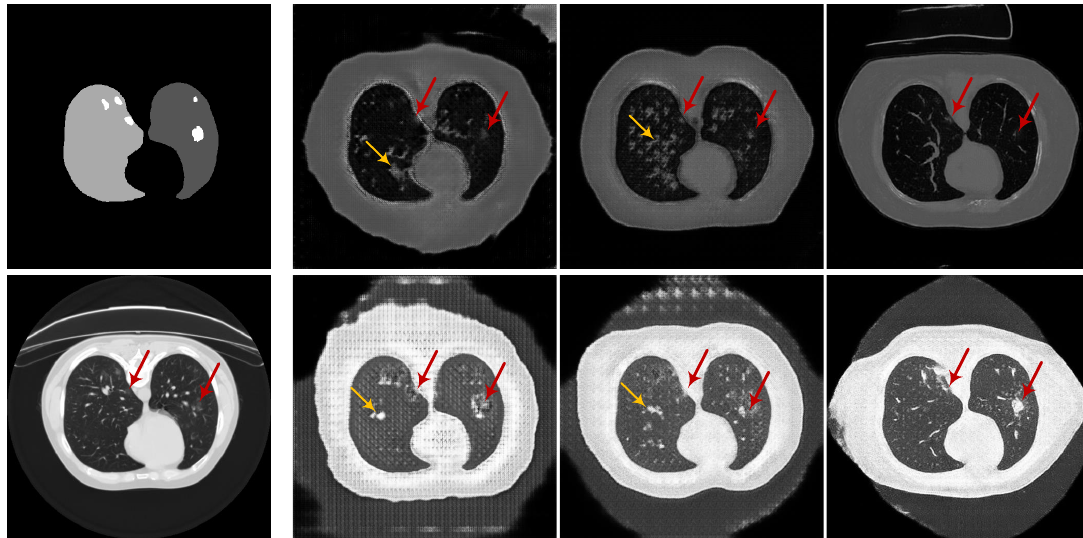
Figure 11. Comparison of synthetic radiological images from different generative models given the same input condition. The input condition and the reference ground-truth radiological image are depicted in the first column. The last three columns are the results of pix2pix, enhanced pix2pix, and CoSinGAN, respectively. Red arrows are used to track and highlight the small infected regions, and yellow arrows are used to indicate the artifacts. The white and gray (e.g., light gray and dark gray) in condition masks represent the infected regions and lungs,